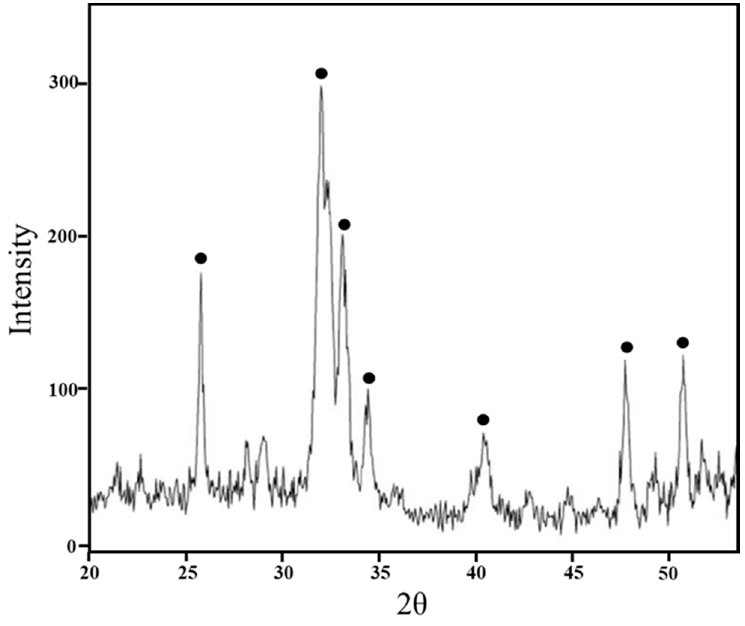
Figure 6. A representative XRD of SiO 2 /PEG 12 wt% /Fe(II)C 15 wt% soaked in SBF solution for 21 days.